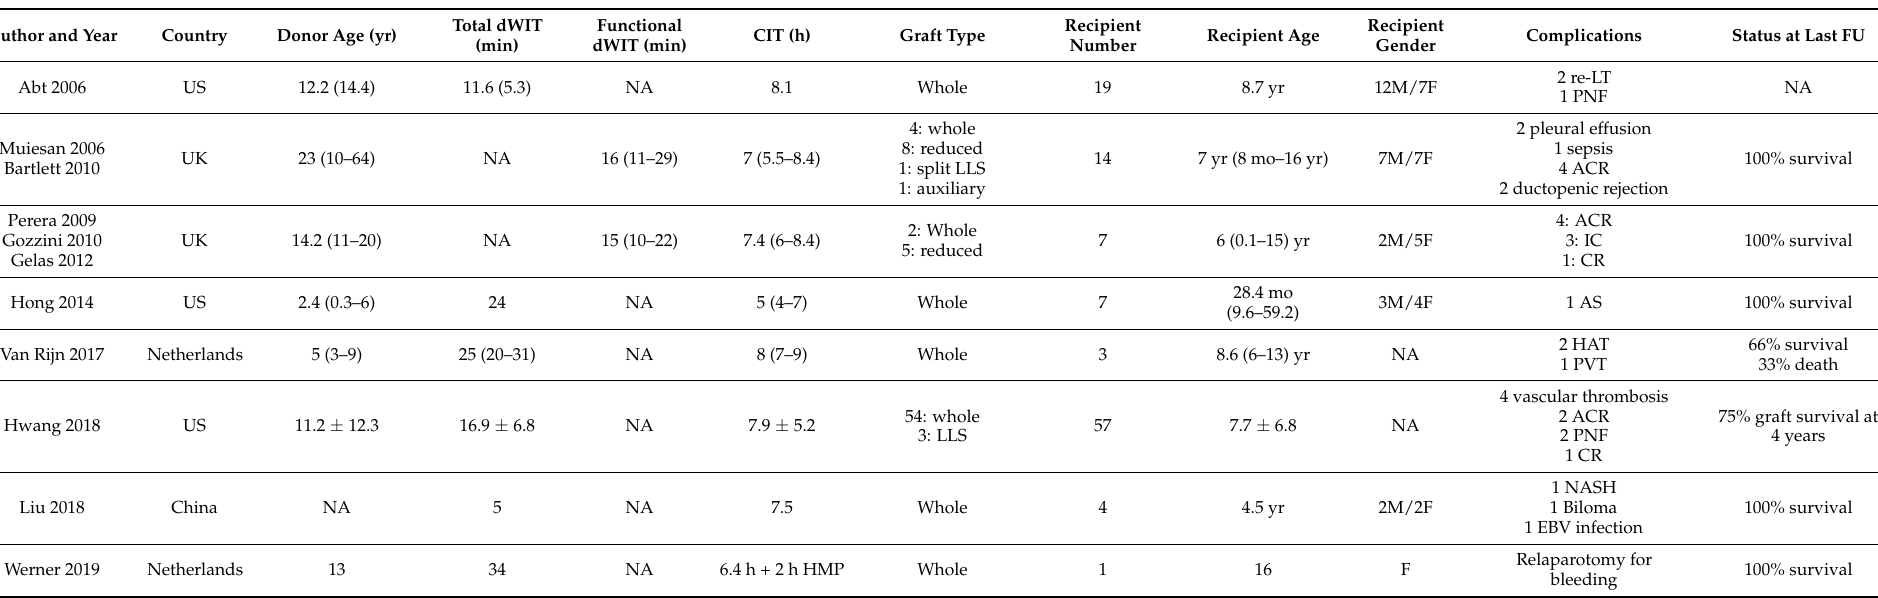
Table 1. Summary of all reported cases of paediatric LT with DCD grafts. Results are presented in mean deviation standard or median and IQR, based on how each study